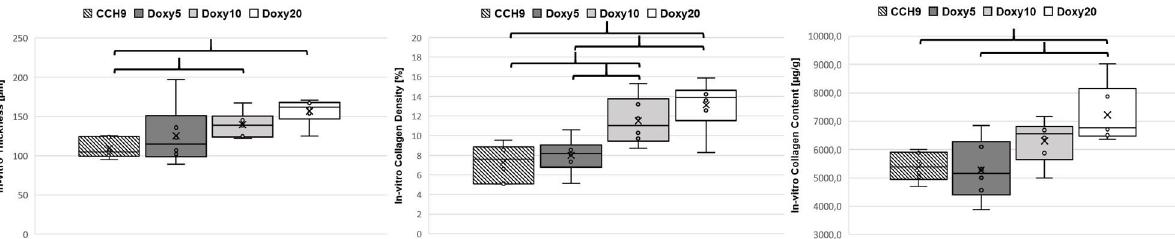
Fig 3. In-vitro results. Results of thickness, density and collagen content measurements. Mean values (X) are graphed on a box plot and individual data points are shown. Density is measured as percentage of stained pixels in relation to the whole image pixel count . Brackets indicate statistically significant differences (p < 0.0125). Group size: n =